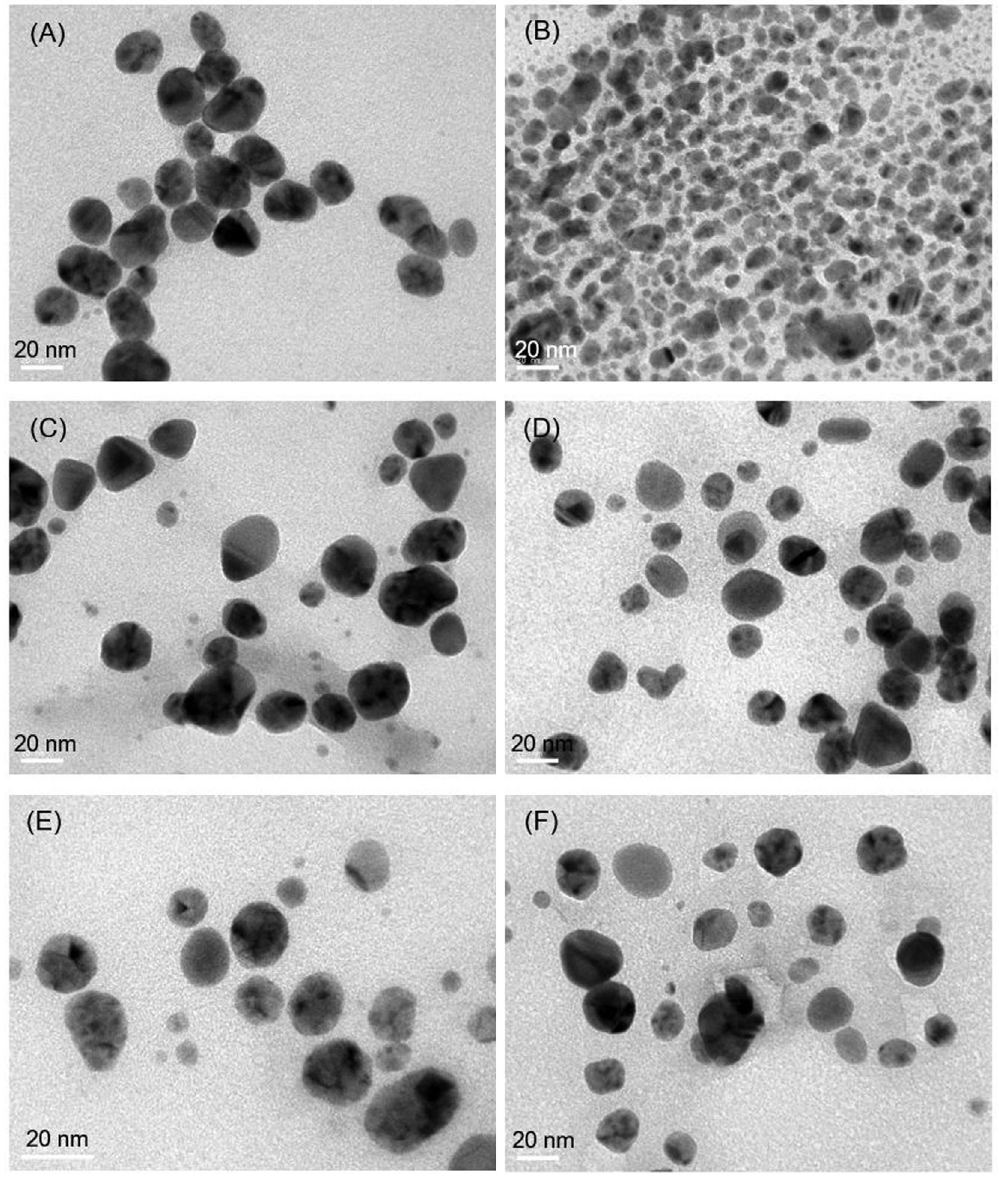
Figure 8: Show TEM images of silver nanoparticles prepared with different LHE concentrations: (a) 0.003 wt%, (b) 0.01 wt%, (c) 0.05 wt%, (d) 0.1 wt%, (e) 0.5 wt% and (f) 1.0 wt%,